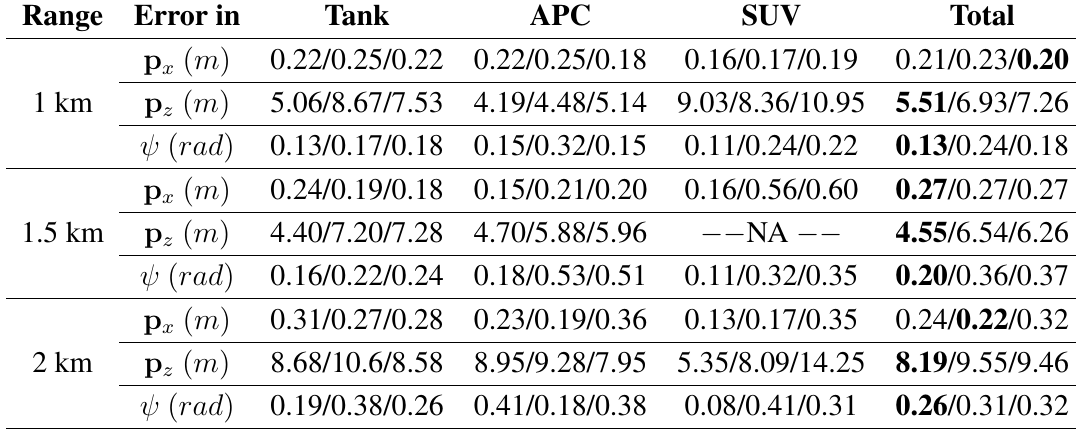
Table 3. Tracking errors for three ATR methods (Method I/Method II/Method III). (Reprint from [28], with permission from IEEE).